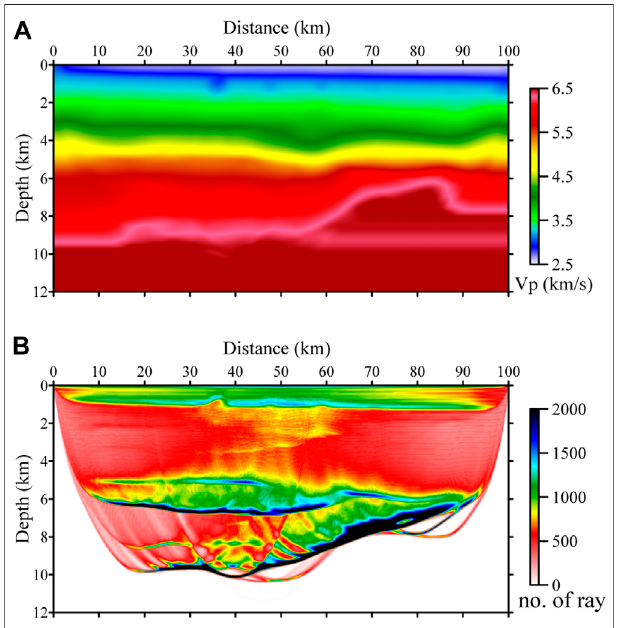
FIGURE 11 | The inverted velocity model (A) with Type-II modi fi ed geometry but without the 10-km receiver arrays in the normal geometry and (B) its ray density map. The interval of extra receivers is 1 km. The maximum offset of the modi fi ed geometry is 50 km.